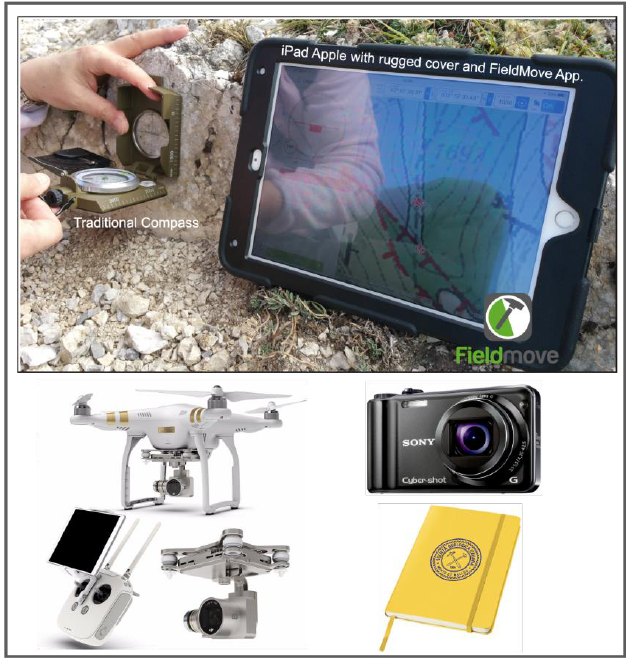
Figure 4. Survey tools used during different fieldwork activities: above: Traditional compass-clinometer and Digital device (Apple iPad Air2) supporting the “Fieldmove” App by Midland Valley & Petroleum Expert, in position for the measurement of a shear plane within a fault breccia; below: Drone model DJI Phantom 3 Professional and details of its components; Sony camera DSC-HX5V with integrated GPS; bottom-right: traditional papery field book.